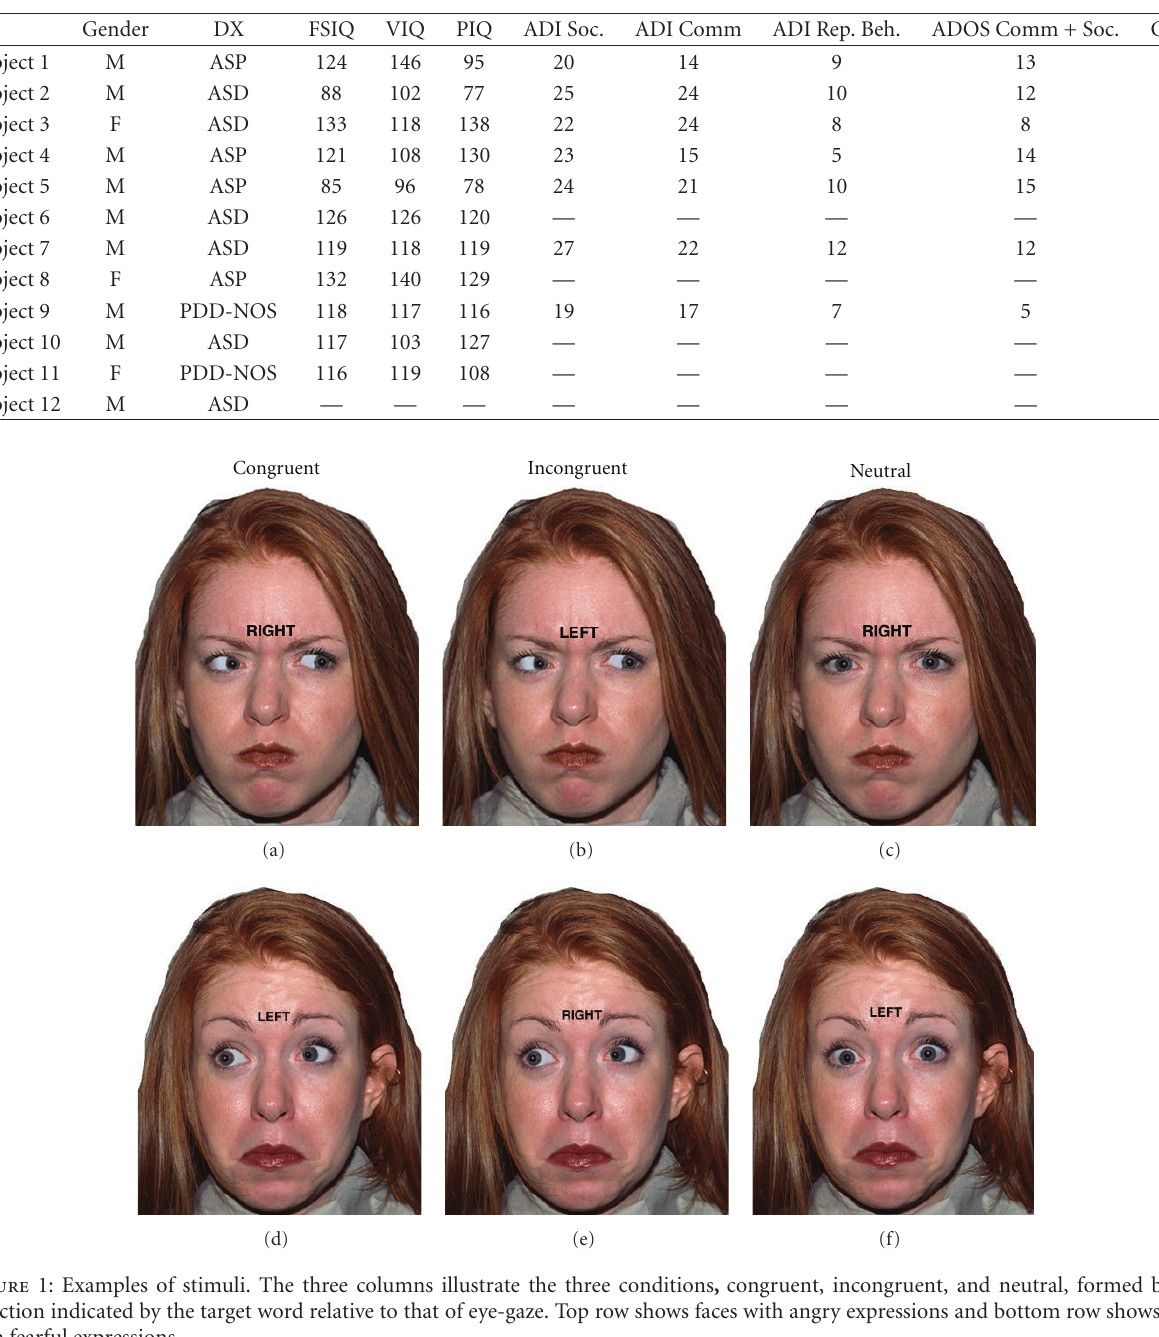
Table 1: Demographic information for ASD children.